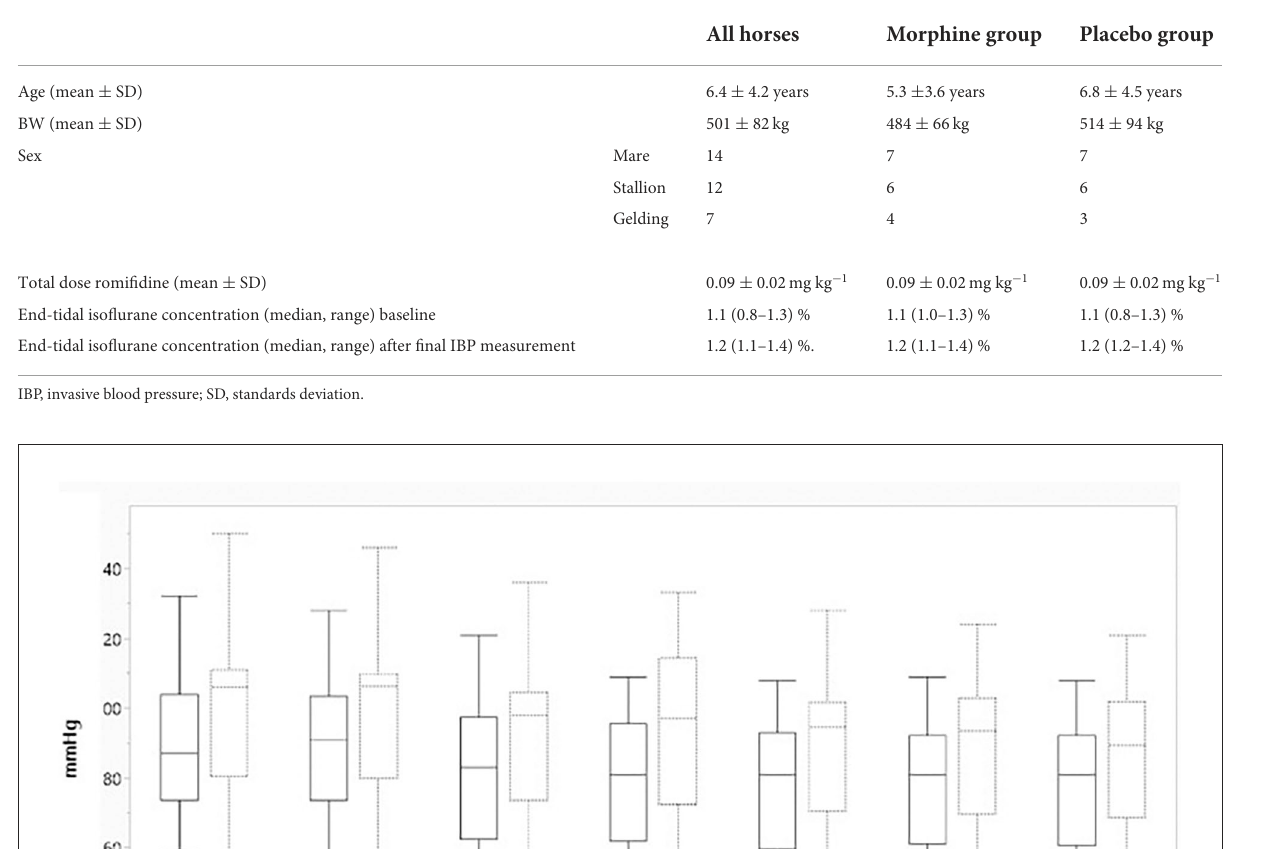
TABLE 2 The table showing demographic data and anesthetic drug doses for all horses and within each group.